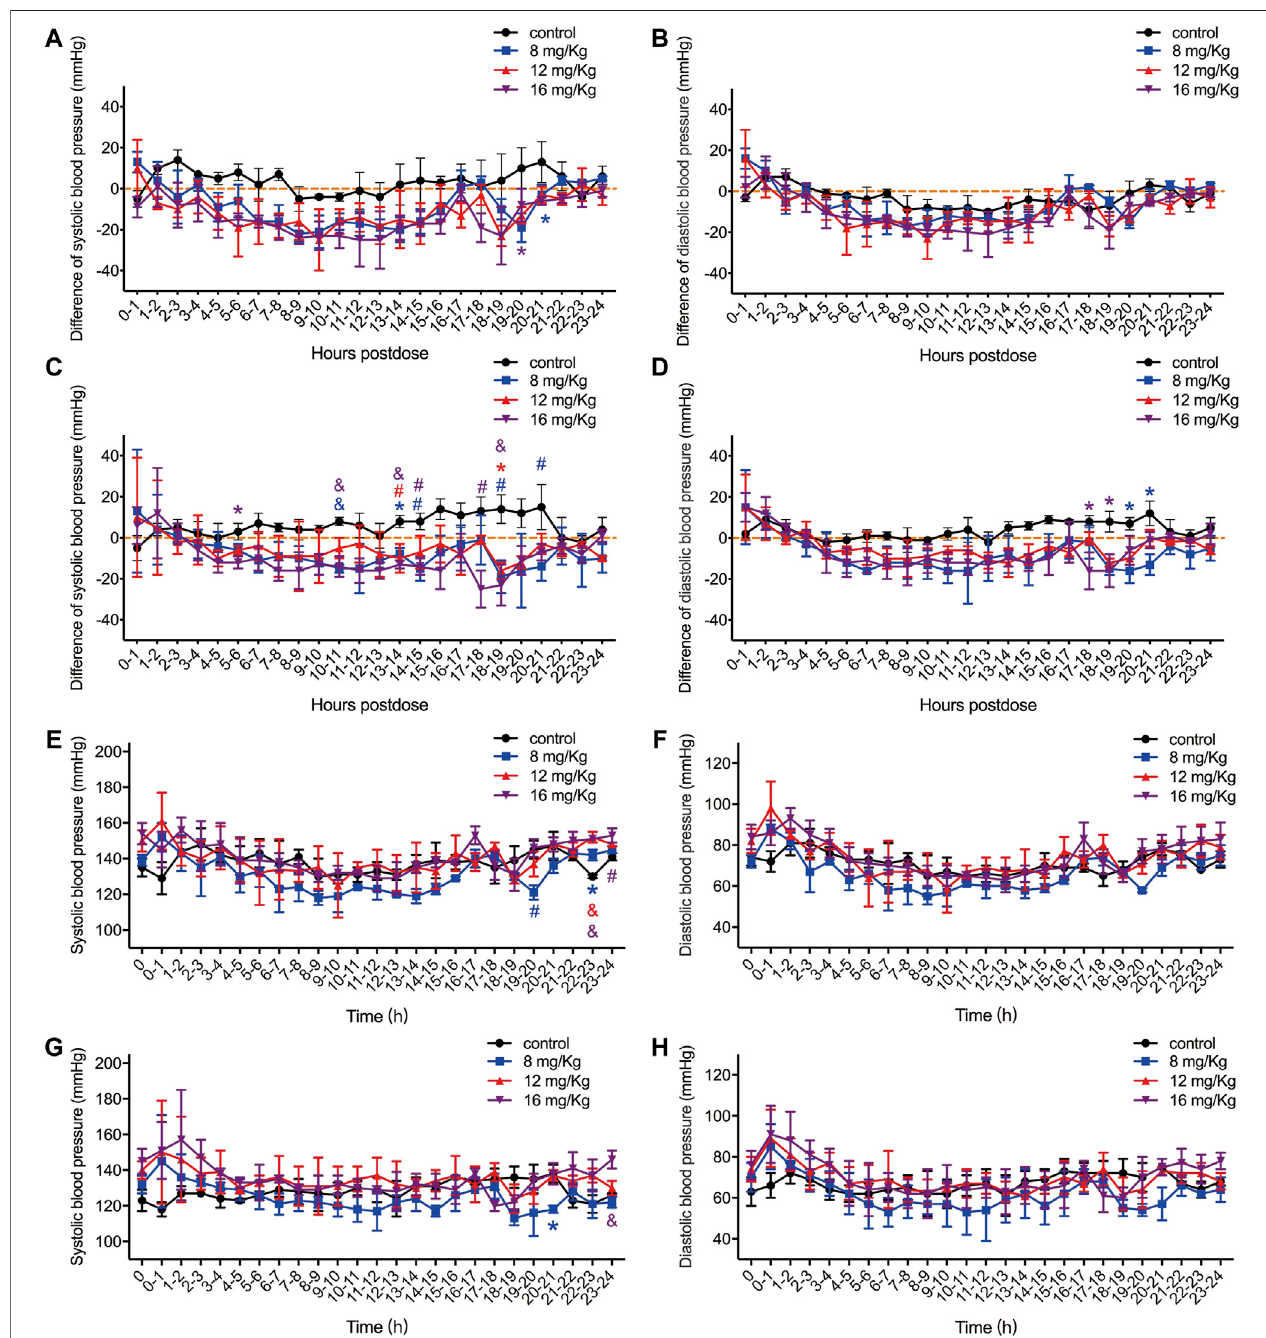
FIGURE2| Thedifferencevalueofsystolicbloodpressure,diastolicbloodpressureand QRSintervalinmale (A – B) andfemale (C – D) rats,andtheoriginalvalueof systolic blood pressure and diastolic blood pressure in male (E – F) and female (G – H) rats. The difference value was calculated from the measured value minus the mean value for the two hours before drug administration. Data were depicted as the mean ± SD. Compared with control group, * p < 0.05; # p ≤ 0.01; & p ≤ 0.001.